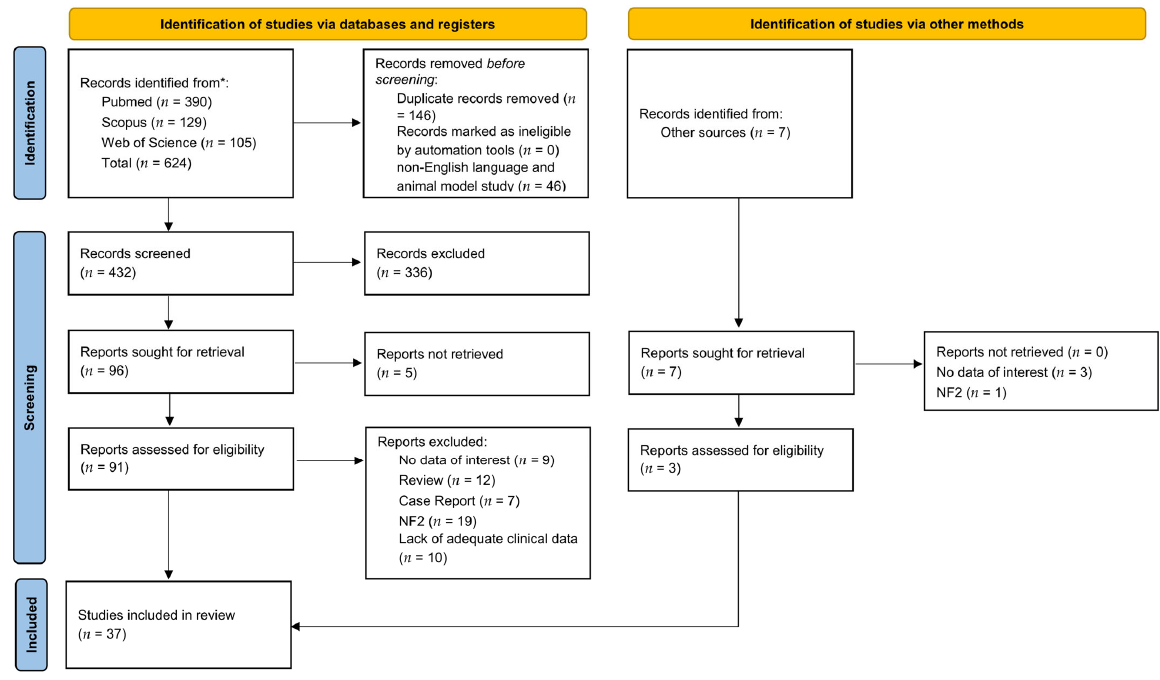
Figure 1. PRISMA diagram summarizing Electronic Database Search and Inclusion/Exclusion process of the review. * date of last search 15 November 2022.